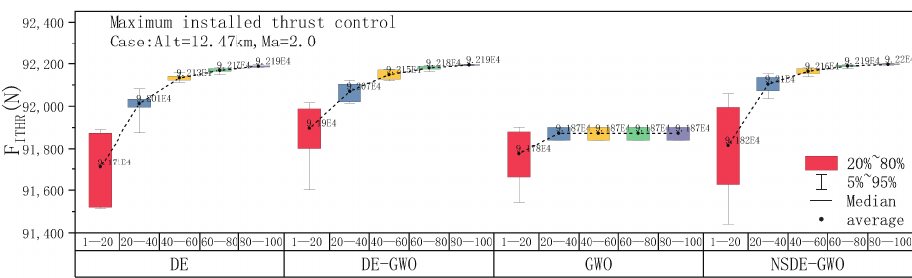
Figure 8. Box plots of different iterative algorithm optimization process in maximum installed thrust control.